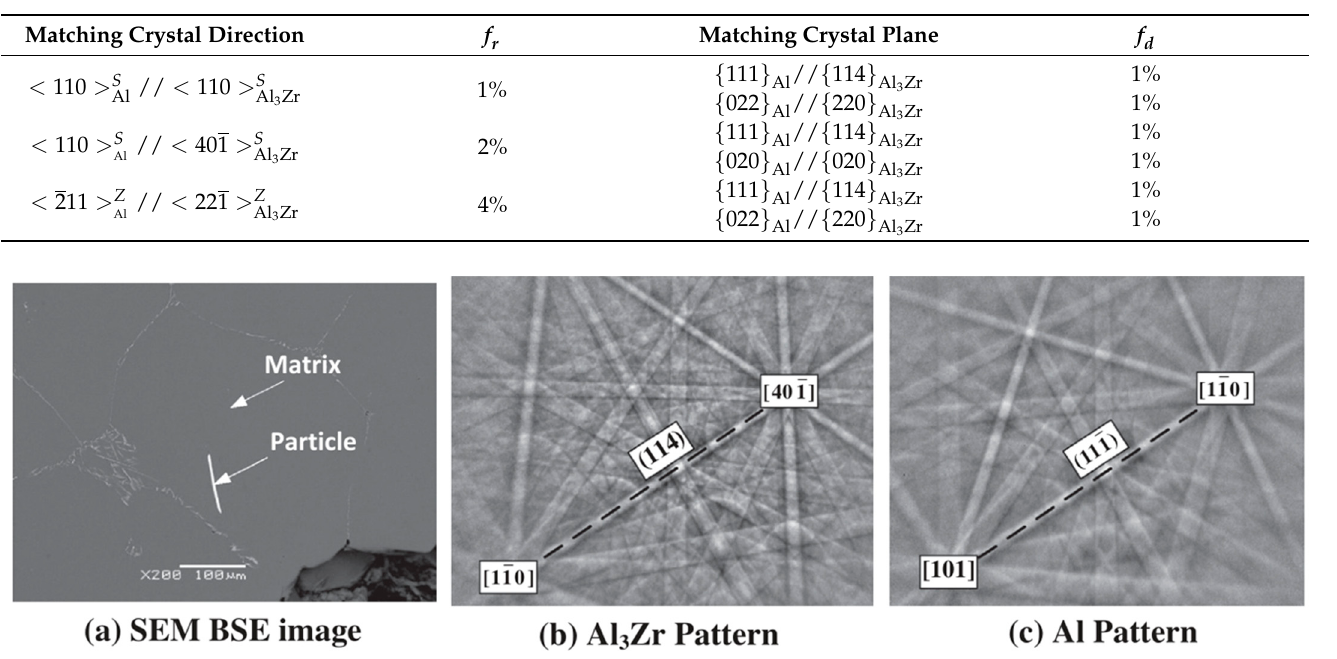
Table 3. Orientation relationship between Al 3 Zr phase and α -Al [28].